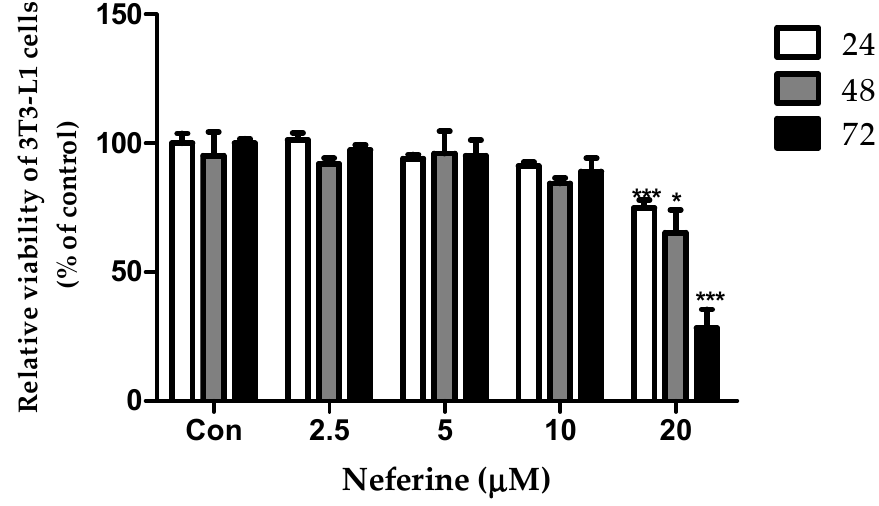
Figure 1. E ff ects of neferine on 3T3-L1 preadipocyte viability. Neferine was used at 2.5, 5, 10, and 20 µ M concentrations for 24, 48, and 72 h. * p < 0.05 and *** p < 0.001 vs. Con. All data are presented as mean ± SD, and experiments were performed for at least three times. The positive control (Con) was di ff erentiated 3T3-L1 cells treated with adipocyte di ff erentiation cocktail.